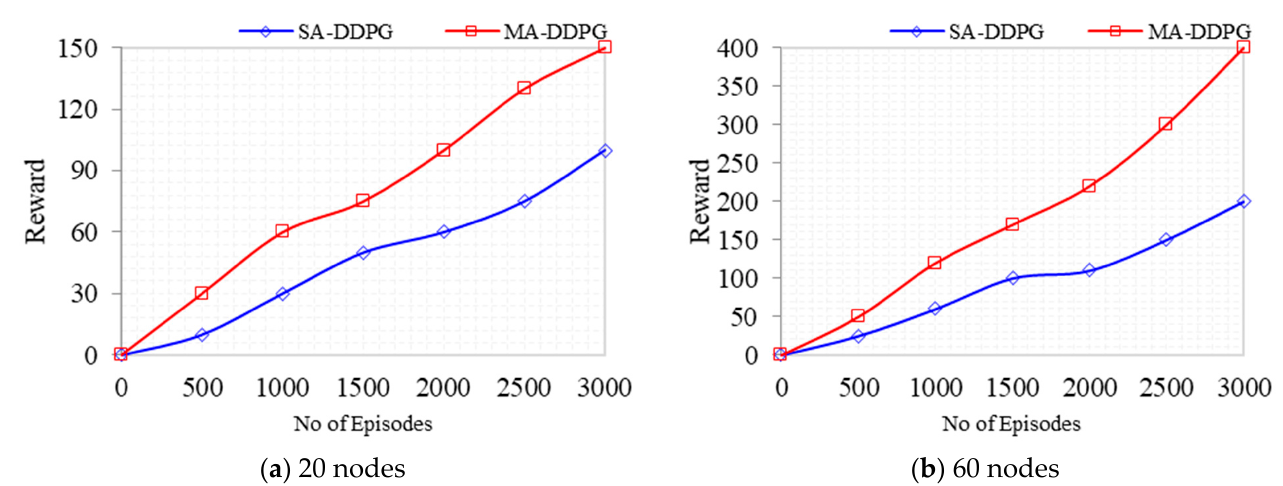
Figure 10. Reward vs. no. of episodes for SA ‐ DDPG and MA ‐ DDPG.